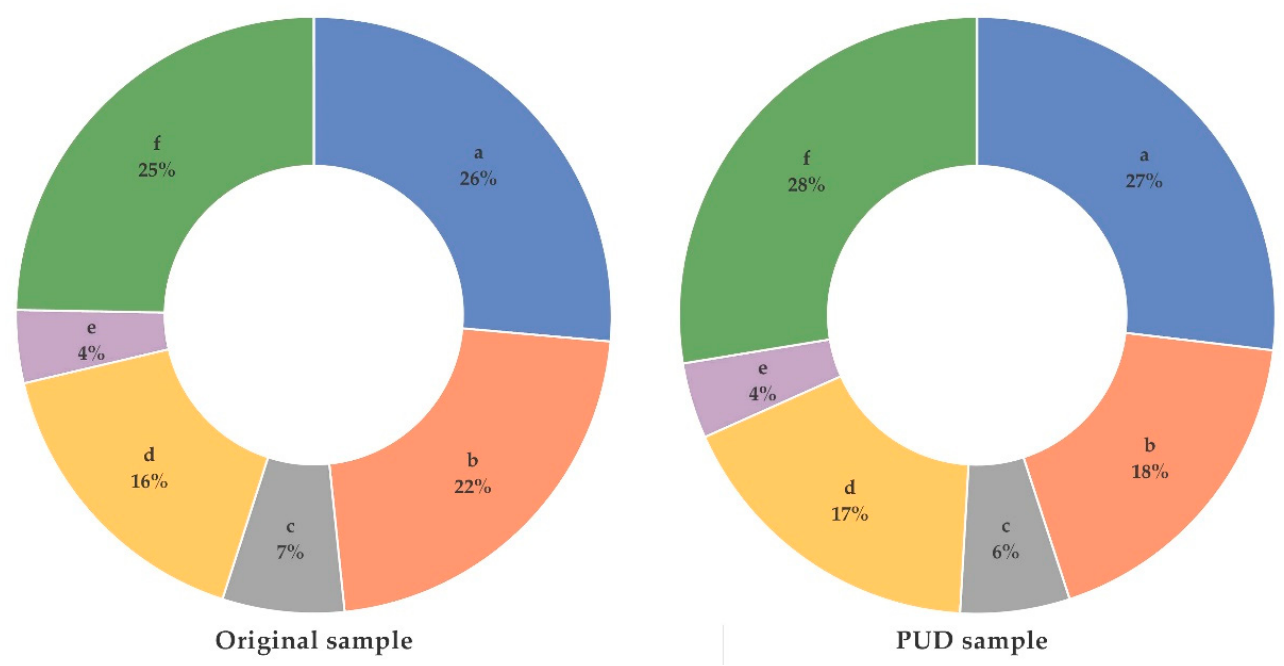
Figure 5. Percentage of each category in each sample: ( a ) natural systems, ( b ) urban systems, ( c ) rural systems, ( d ) recreational activities, ( e ) cultural activities, and ( f ) water bodies.